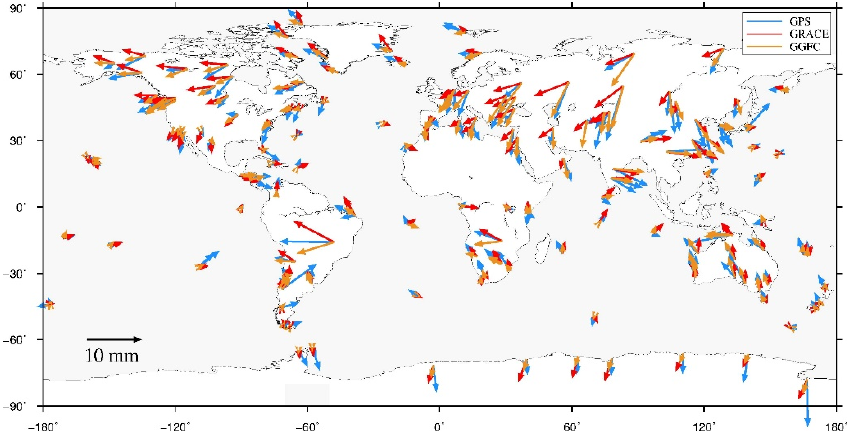
Figure 2. Harmonic annual vertical deformation (VD) derived from GNSS (blue), Gravity Recovery and Climate Experiment (GRACE) (red) and Global Geophysical Fluid Center (GGFC) (yellow) for monthly time series. The length of the vector represents the seasonal amplitude, and the vector direction points directly to the direction of the initial phase angles.